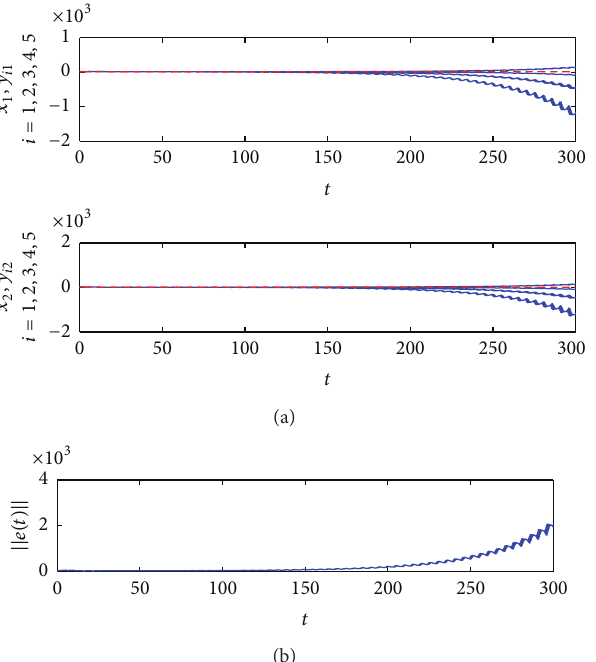
Figure 2: Evolution of (a) state trajectories of drive and response systems and (b) projective synchronization error without impulsive control when 𝜏(𝑡) = 5 − 𝑒 −𝑡 .